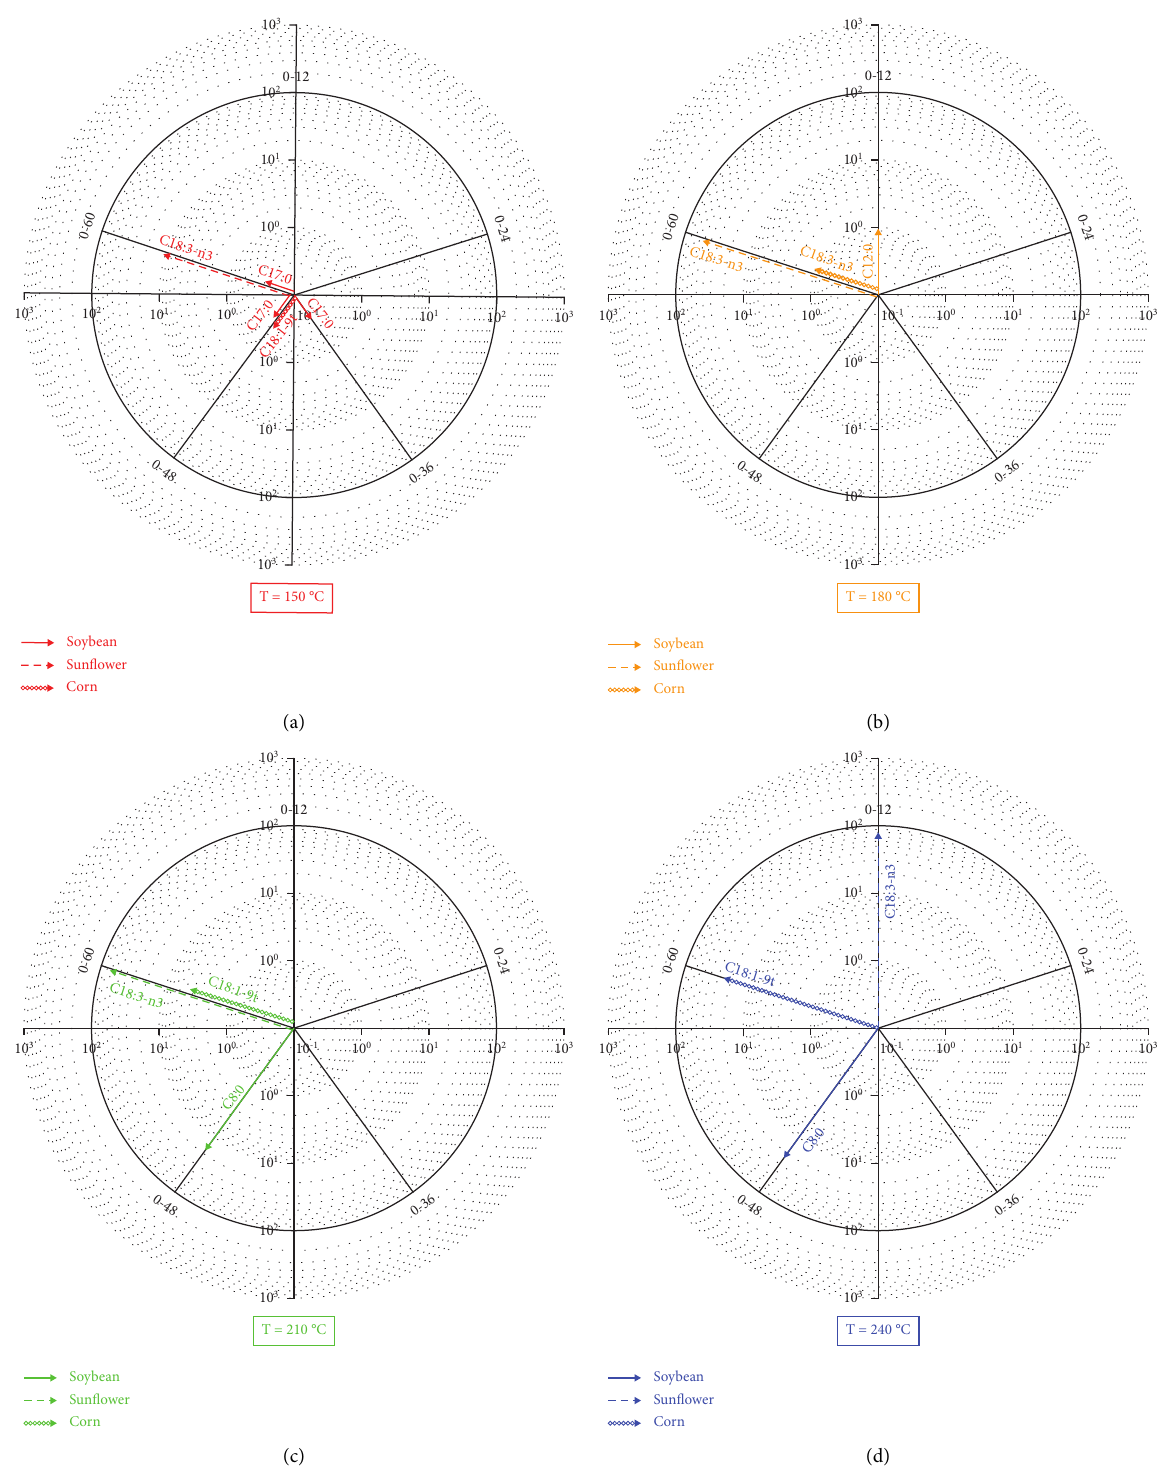
Figure 3: Heating time variations (in hours) leading to maximum change rate of fatty acids over all the three species at different temperatures: (a) at 150 ° C, (b) at 180 ° C, (c) at 210 ° C, and (d) at 240 ° C. The vector length and direction designate the change rate of the fatty acid and the heating time variation, respectively. The fatty acid compositions are written as supplementary explanatory